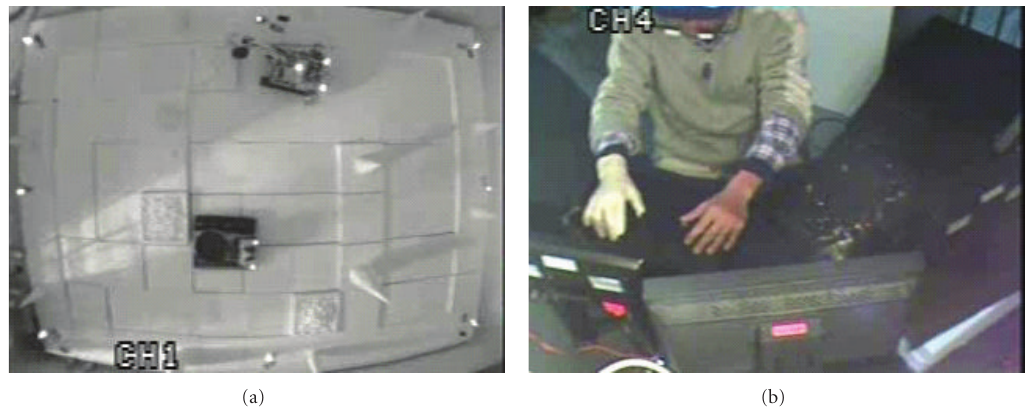
Figure 8: Sample footage for discrimination analysis: (a) view of the work area, (b) view of console